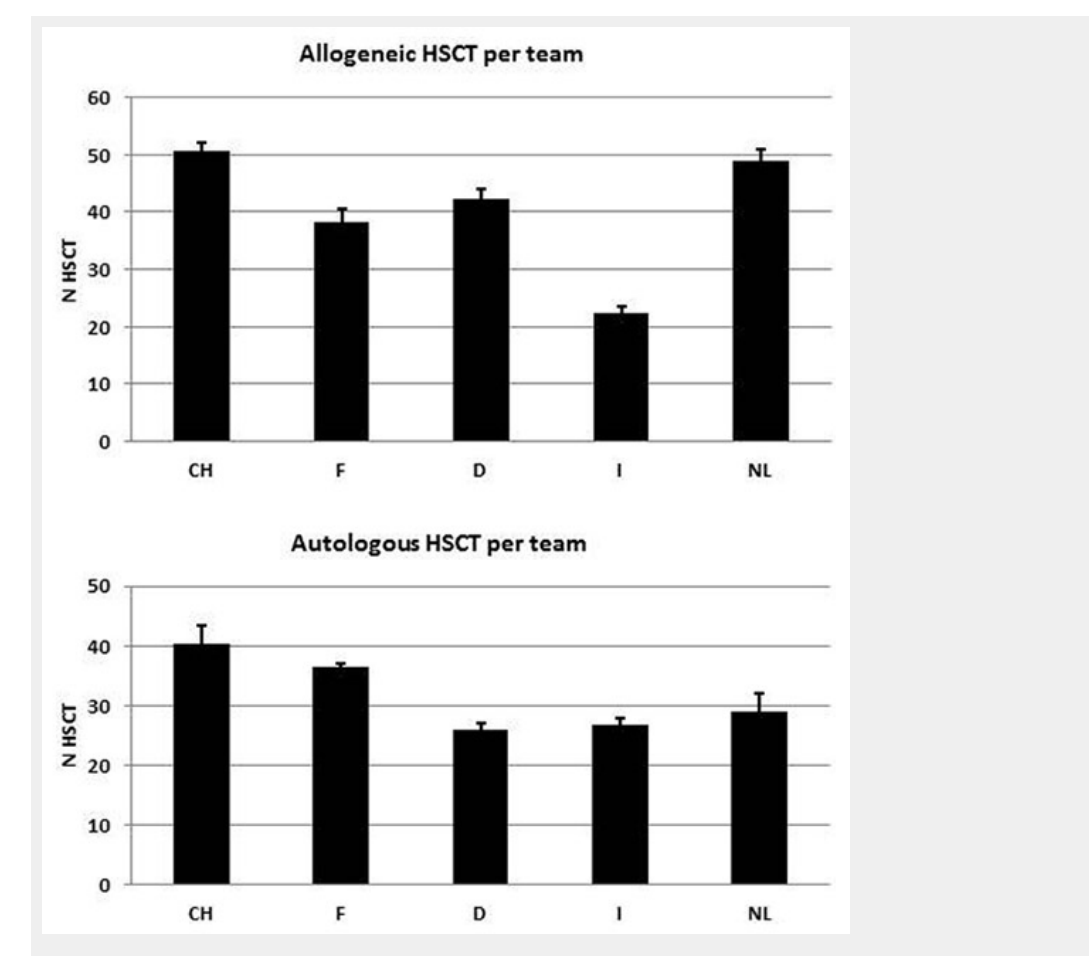
Figure 7 Average annual number of allogeneic and autologous HSCT per transplanting team. 7a: allogeneic HSCT. 7b: autologous HSCT (CH: Switzerland, F: France, D: Germany, I: Italy, NL: the